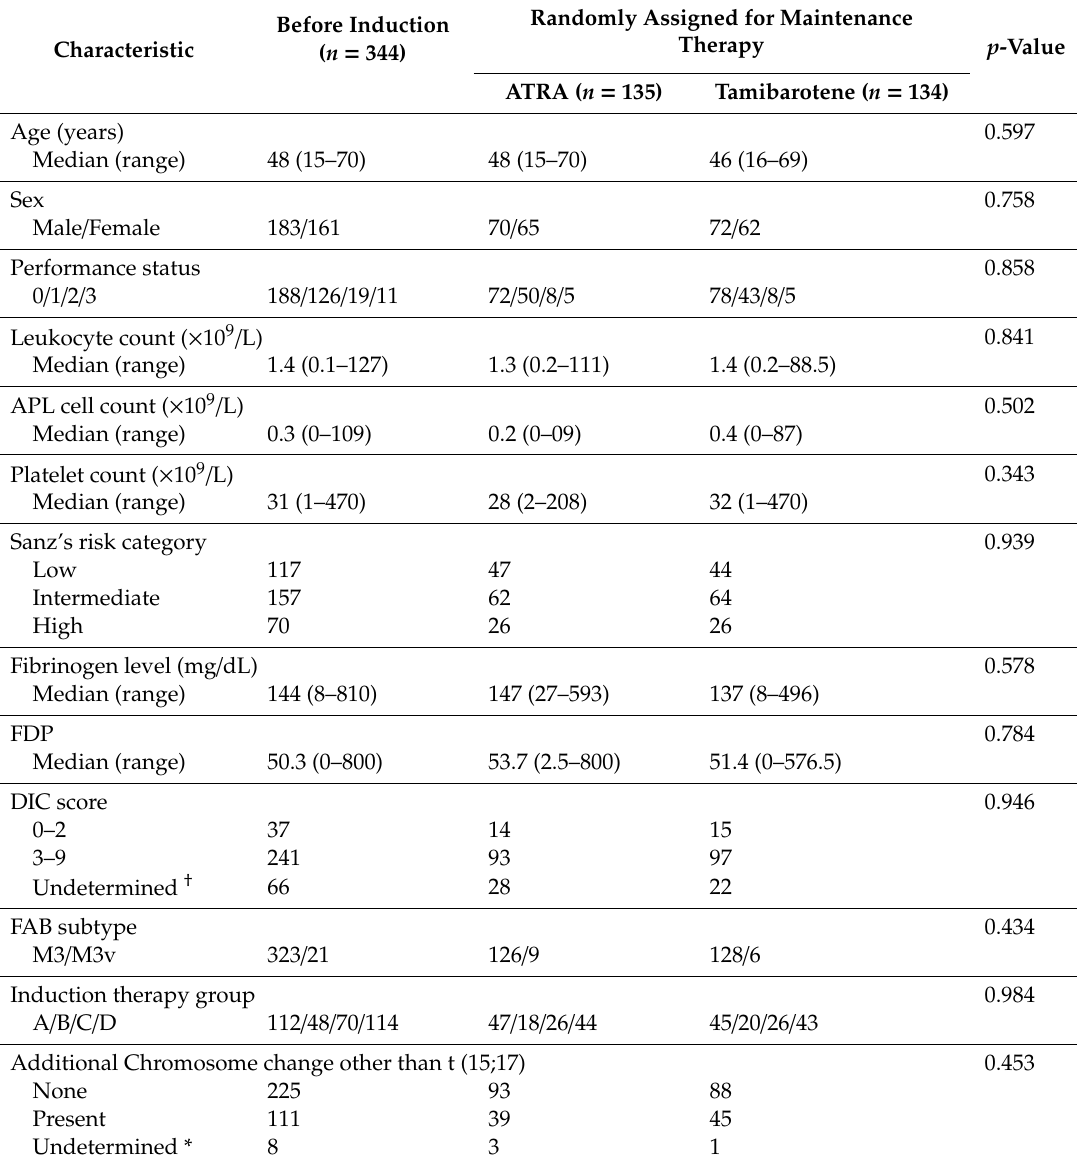
Table 1. Demographics and Clinical